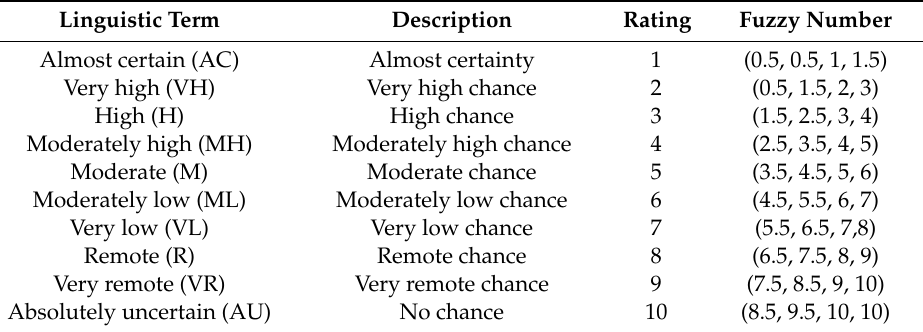
Table 3. Fuzzy evaluation criteria of detectability.